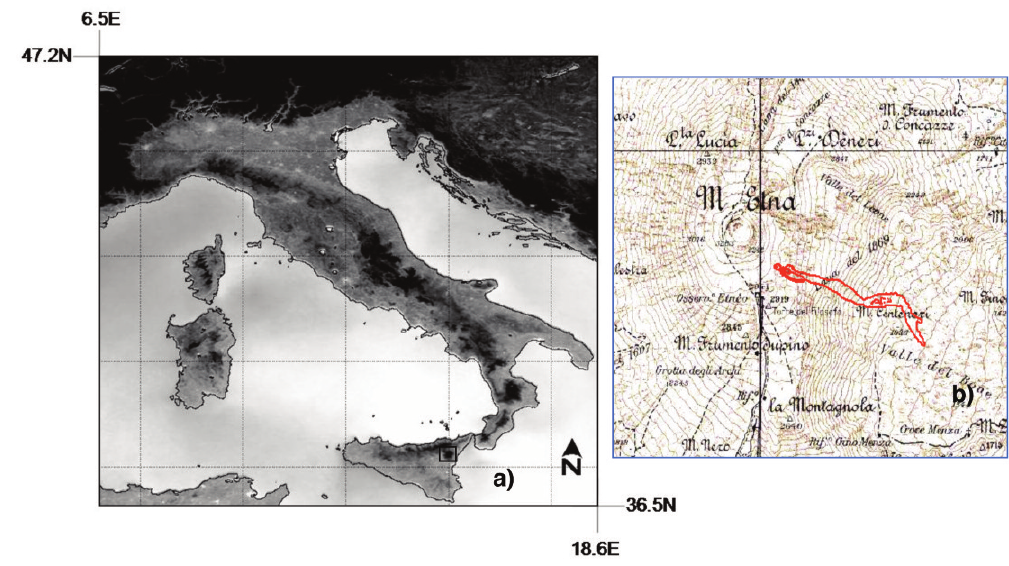
Figure 1. a) The sub-scene extracted from the original Level 1b MODIS data reprojected in LAT/LONG WGS84 that was used by RST processing, showing the Mount Etna area (blue square). b) Map of the lava flow at Mount Etna of July 24, 2006 (from the Italian Department of